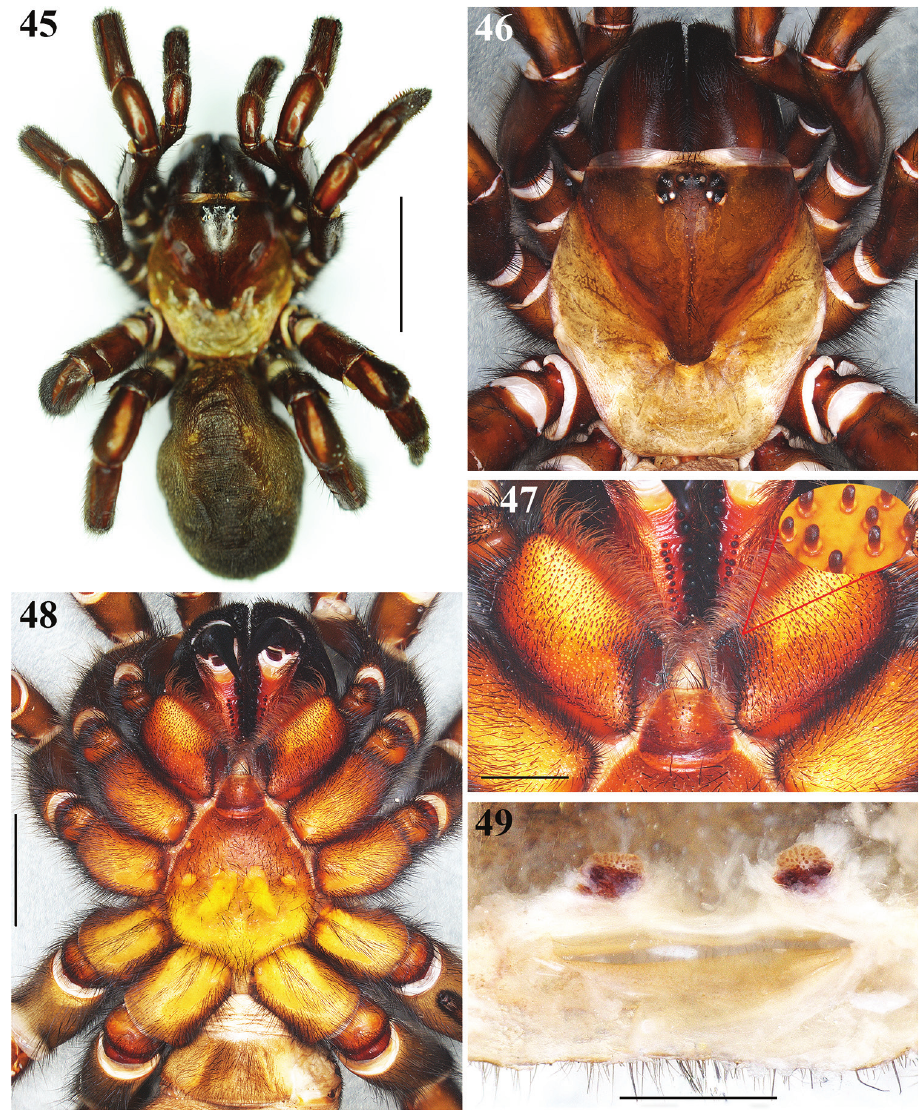
Figures 45–49. Eucteniza zapatista Bond & Godwin, 2013. Female: 45 Habitus dorsal 46 carapace, dor- sal view 47 Endites, ventral view; detail of the cuspules 48 Prosoma, ventral view showing coxae, sternum, labium and endites 49 Spermathecae, dorsal view. Scale bars 1 mm ( 49 ), 2 mm ( 47 ), 5 mm ( 46 , 48 ), 10 mm ( 45